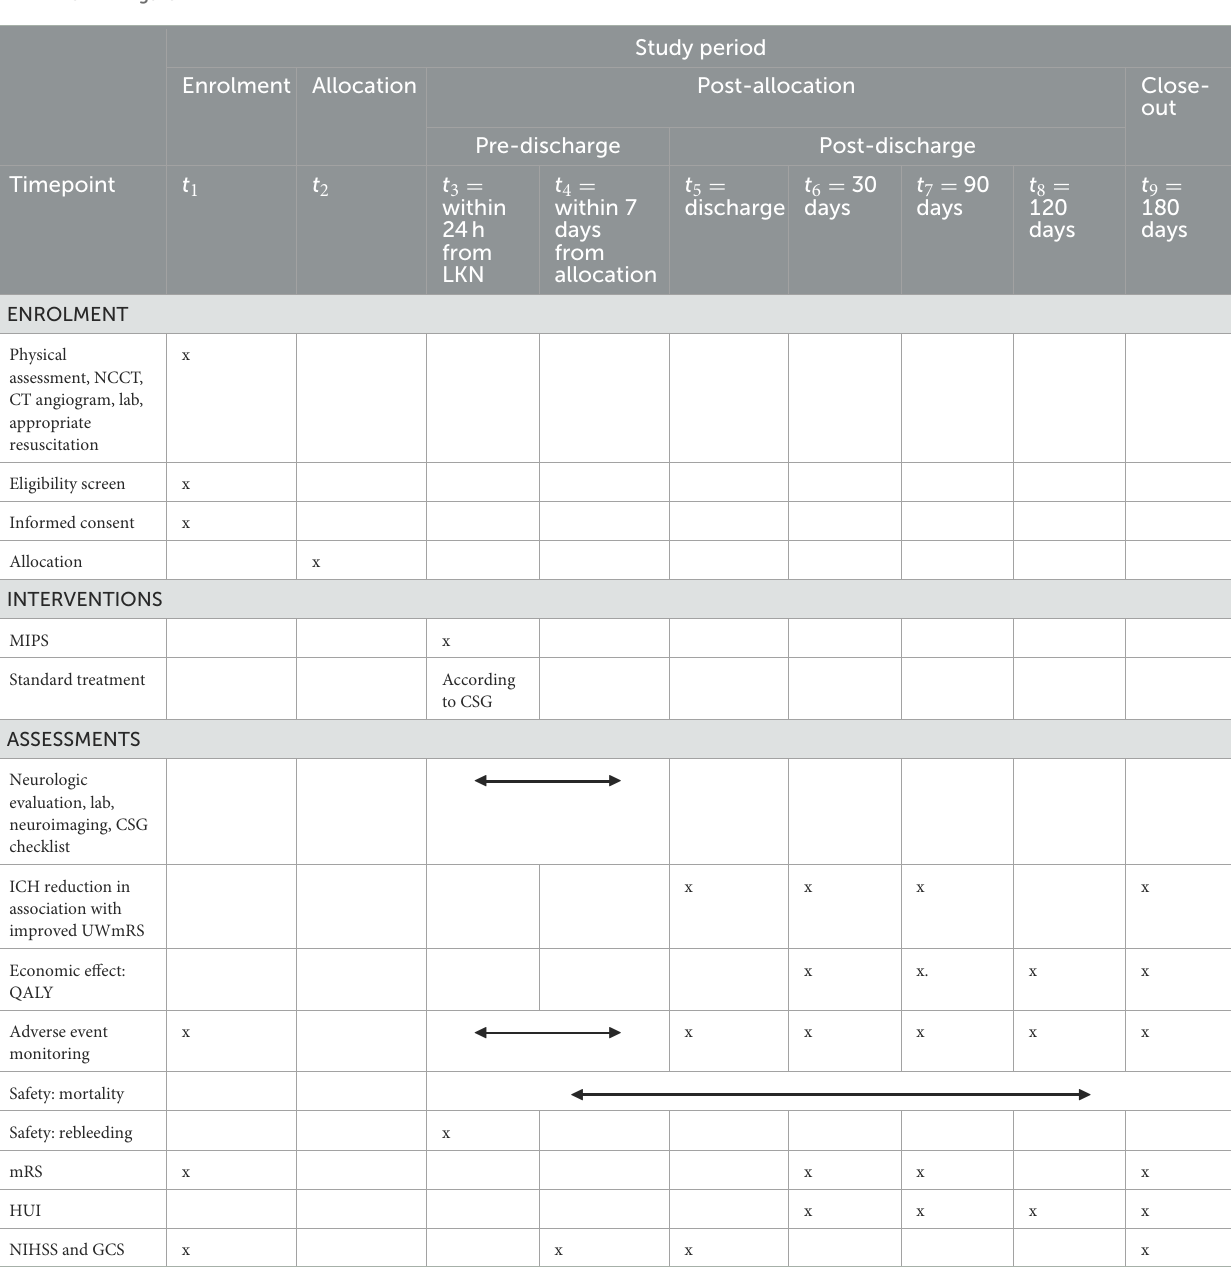
TABLE 1 SPIRIT figure. Enrolment Allocation Post-allocation Close-